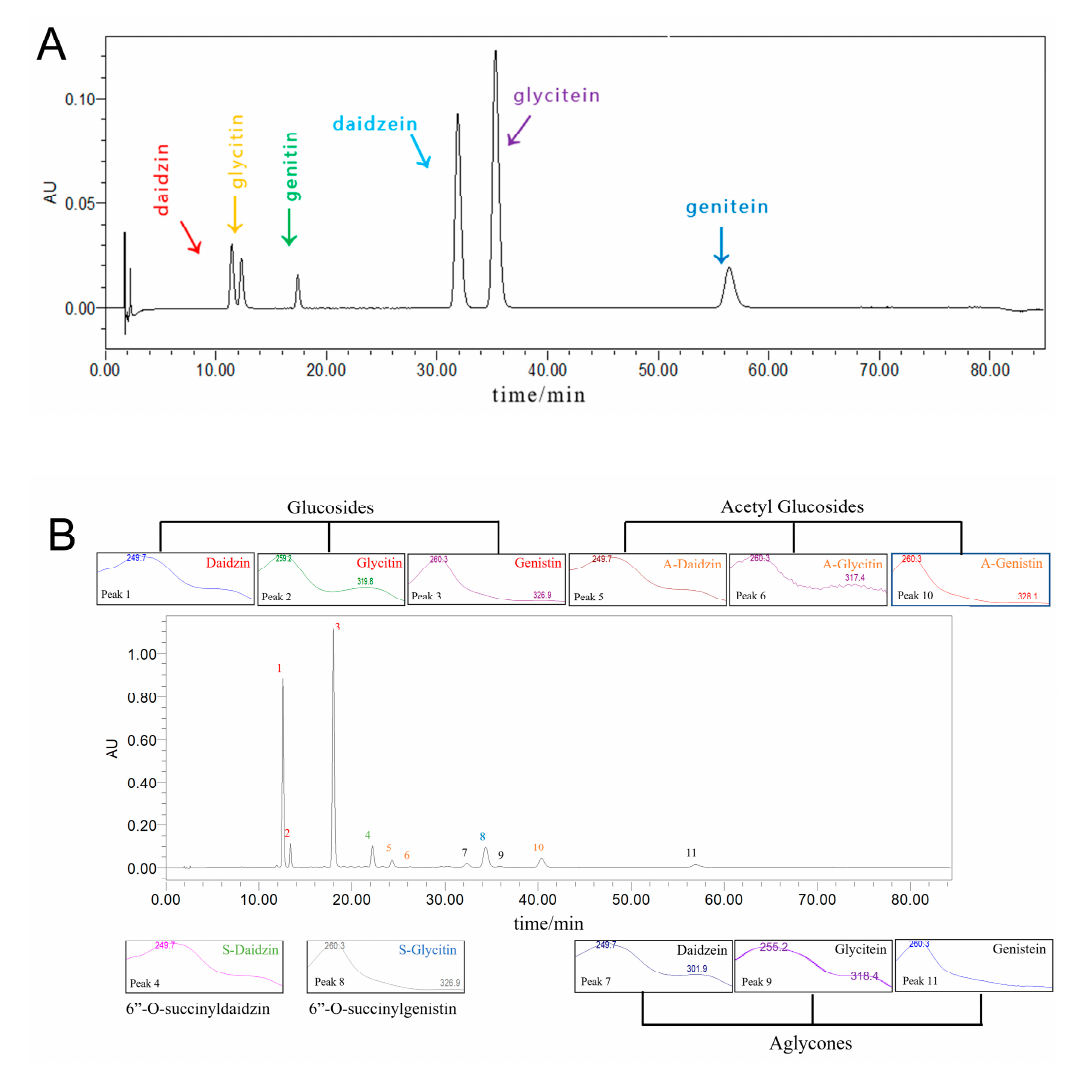
Figure 4. HPLC diagram of mixed soybean isoflavone standards ( A ) and HPLC chromatograms of the sample purified and standards of soy isoflavones by AB-8 macroporous resin ( B ), as recorded at 254nm. The numbers of the peaks are as follows: 1. Daidzin; 2. Glycitin; 3. Genistin; 4. 6 ″ - O - succinyldaidzin; 5. 6 ″ - O -acetyldaidzin; 6. 6 ″ - O -acetylglycitin; 7. Daidzein; 8. 6 ″ - O -succinylgenistin; 9. Glycitein; 10. 6 ″ - O -acetylgenitin; 11. Genistein.